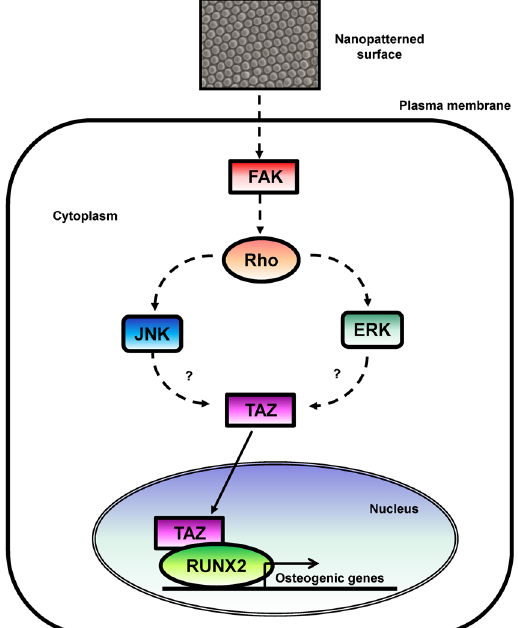
Figure 7. Experimental model. Nanotopological signal stimulates FAK and following downstream ERK and JNK, which activates TAZ and facilitates its nuclear localization. Activated TAZ stimulates RUNX2-mediated gene transcription and induces osteogenic